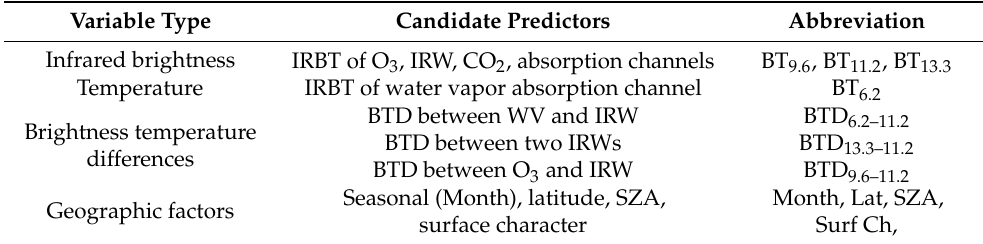
Table 1. List of candidate